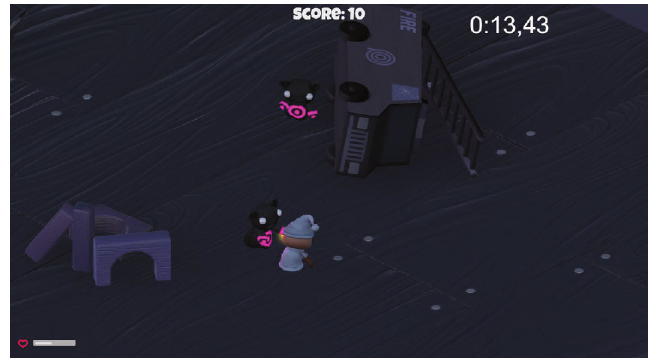
Figure 6: Screenshot of a 3D shooter computer game.